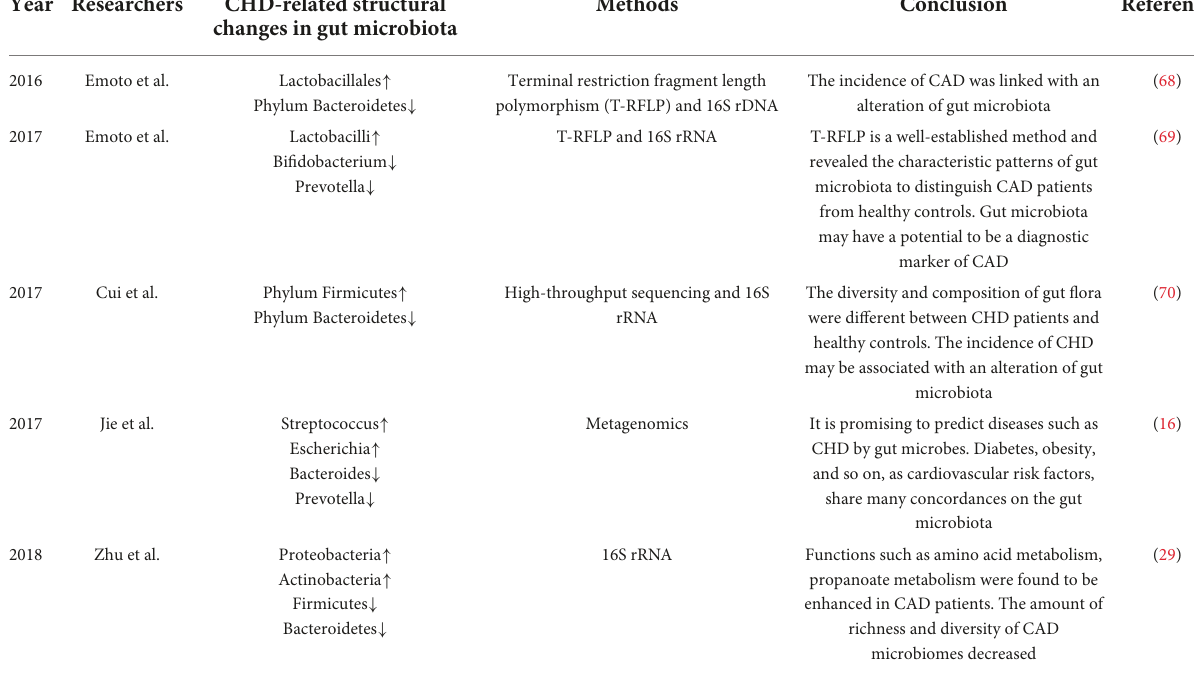
TABLE 8 CHD-related structural changes in the gut microbiota. Year